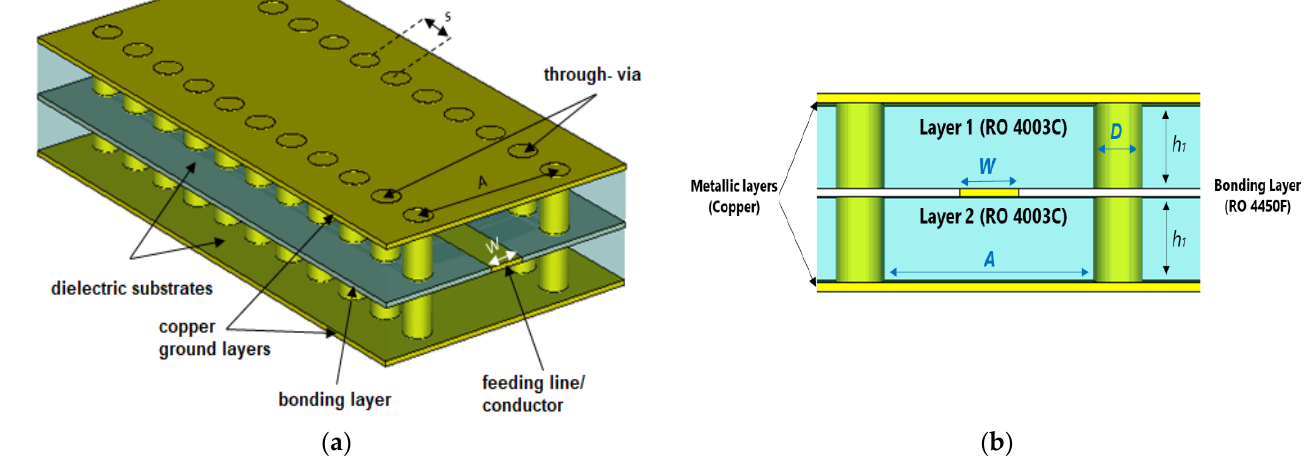
Figure 2. Designed Substrate-Integrated Coaxial Line (SICL). ( a ) Top-view diagram; (b) side-view